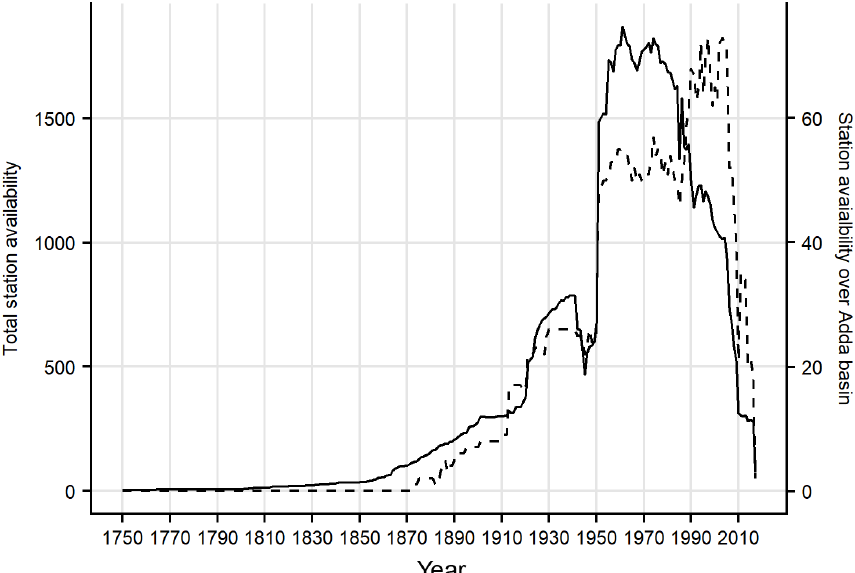
Figure 2. Availability of monthly precipitation records over the whole period spanned by the database considering all stations (solid line) and only stations located inside upper Adda river catchment (dashed